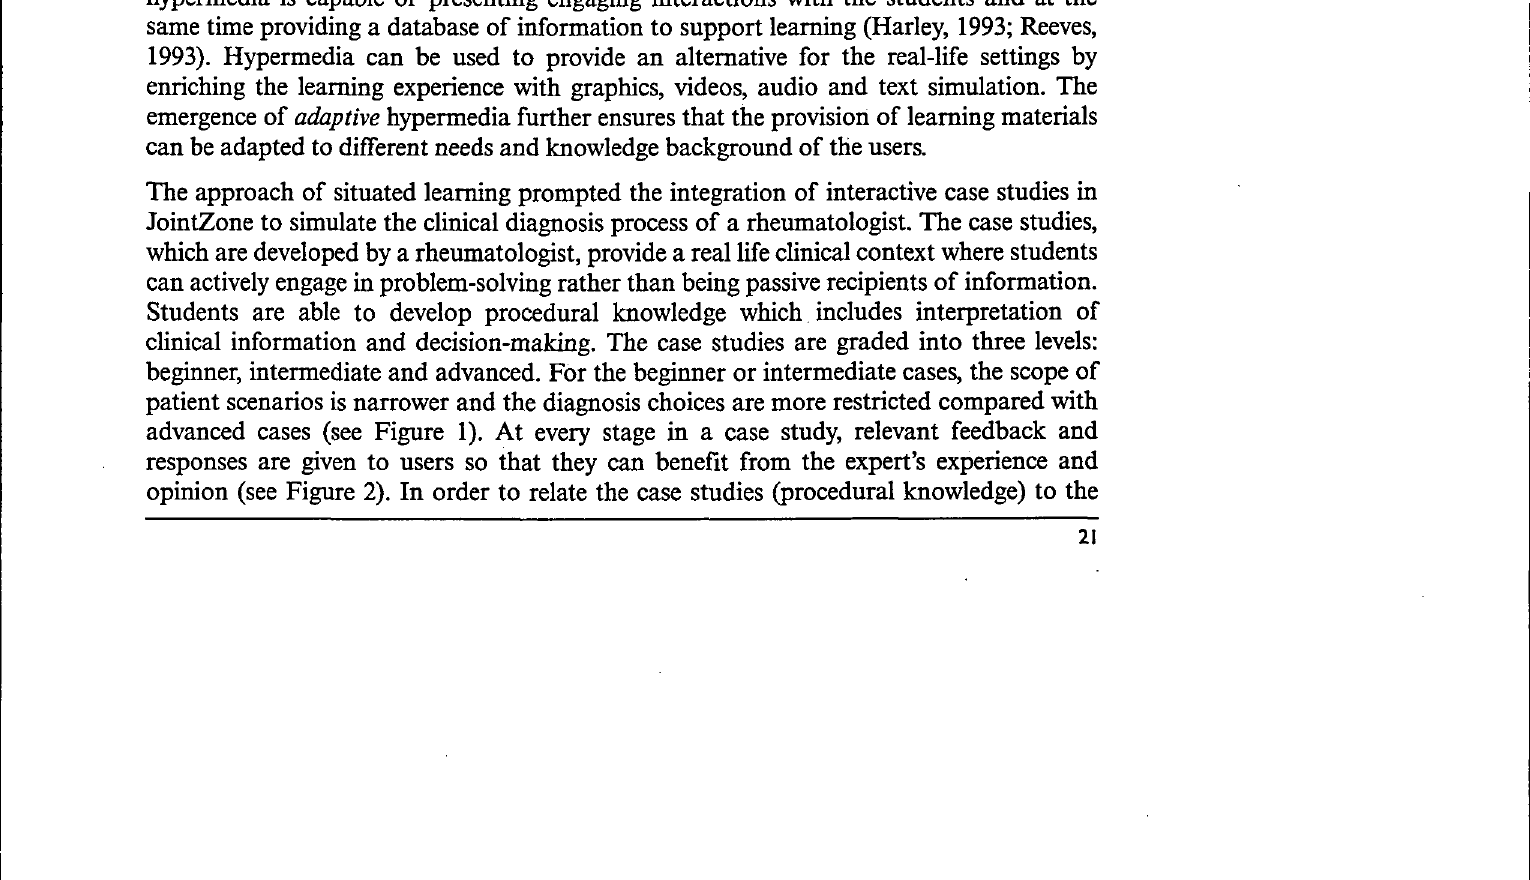
Figure I: The advance case study gives wider scope of user choices gained is embedded in a social or physical context. The theory suggests that learning through real-life experiences produces more usable and robust knowledge (Brown et al, 1989) as compared with inert knowledge (Whitehead, 1929) that is only useful in